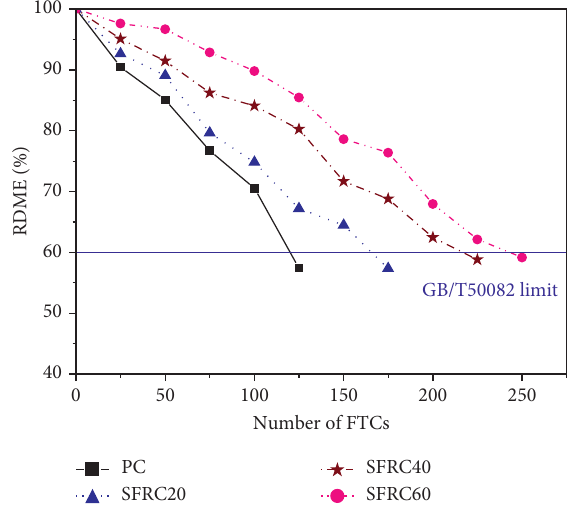
Figure 3: Variation of the RDME of the samples after different